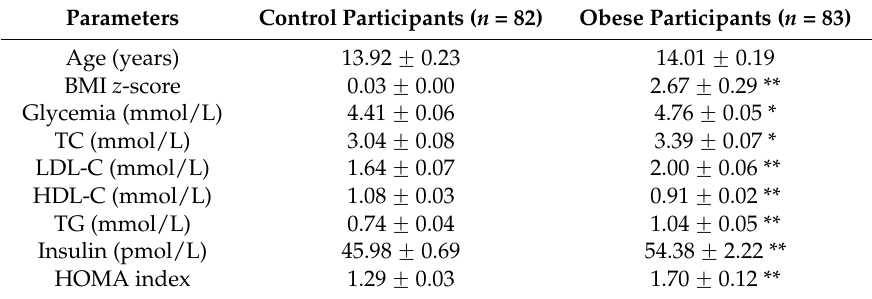
Table 1. Characteristics of study groups and concentrations of blood parameters between controls and obese